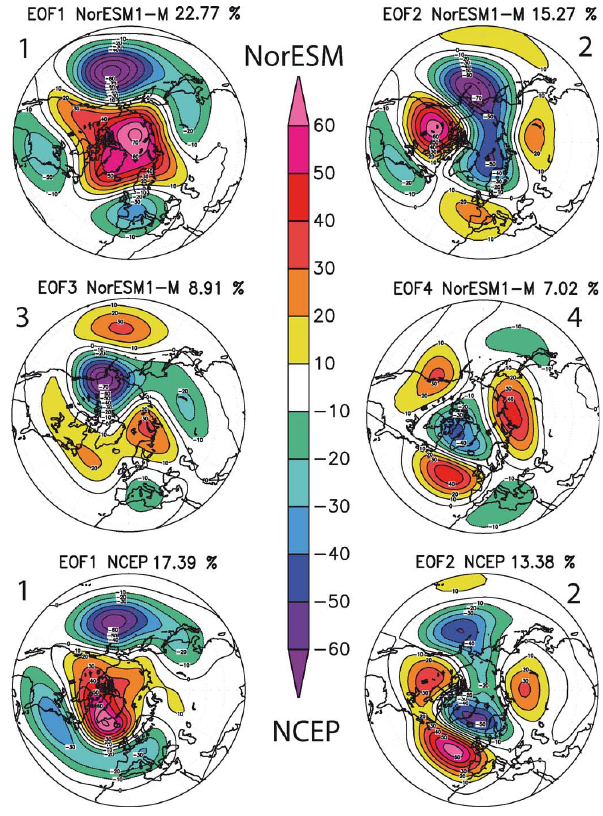
Fig. 14. First and second rows show the 500-hPa-geopotential height associated with the 4 leading EOF-vectors for detrended, monthly average anomalies of the 500hPa geopotential height for December–March over the years 1976–2005, based on the three en- semble members (Historic1, 2, and 3) simulated with NorESM1-M. Seasonal variations are removed by calculating anomalies relative to the 30-yr average for each month, while trends are removed by subtracting the 5-yr moving average. The third row shows the cor- responding maps of the 2 leading eof-vectors calculated in the same way for the same 30yr using the NCEP re-analysis data (Kalnay et al.,